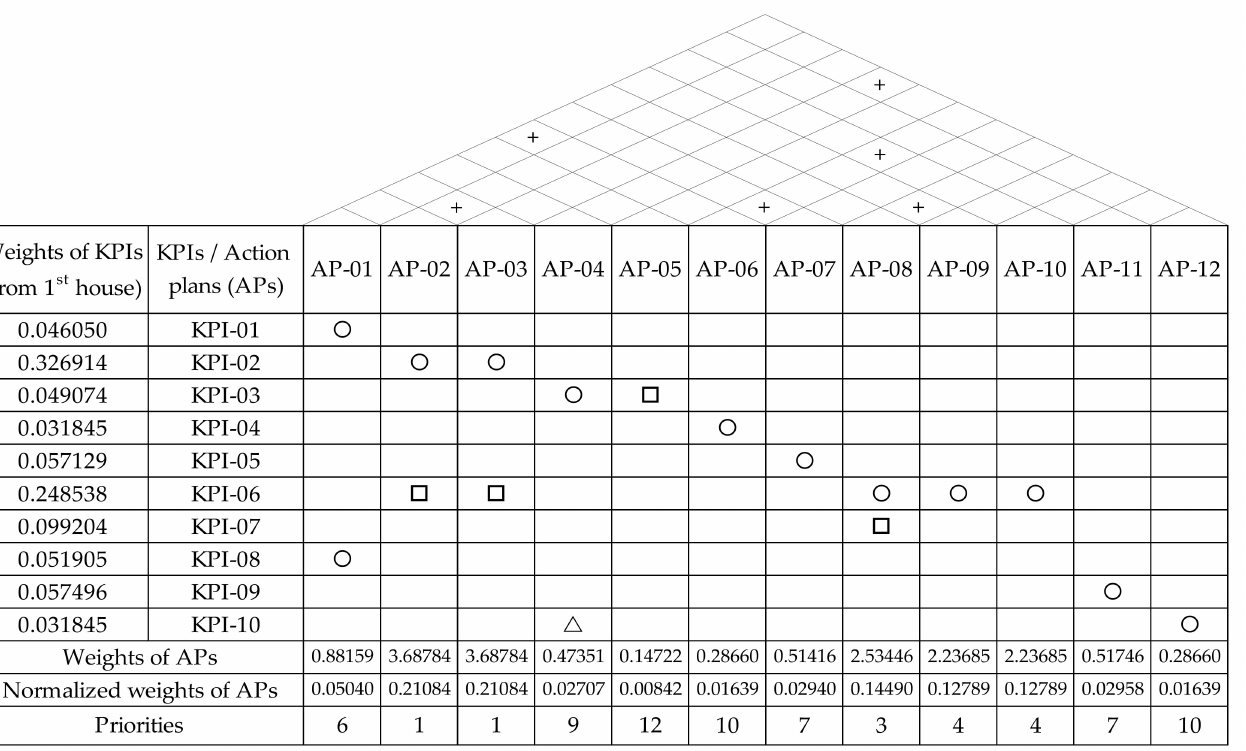
Figure 7. Results of the second house of QFD